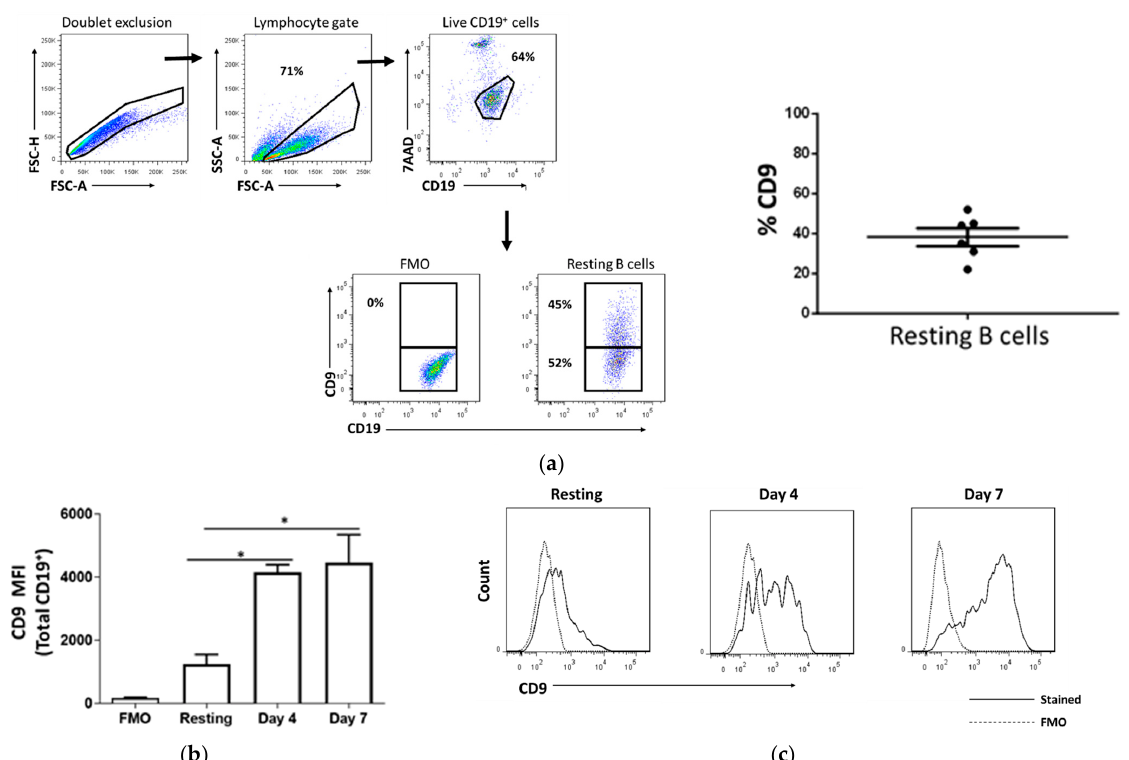
Figure 1. CD9 is expressed in resting tonsillar B cells and upregulated upon T cell-like (TCL) stimulation. B cells were purified from the tonsil using magnetic beads and analyzed for phenotypic CD9 expression. ( a ) Gating strategy for CD19 + B cells and its CD9 expression. ( b ) Purified naïve B cells were activated with TCL stimulation cocktail, CD40-agonist/anti- IgM/IL-2. On day 4 and 7, subsequent changes in CD9 expression were assessed and compared between the resting and stimulated B cells. ( c) Representative histogram showing the mean fluorescence intensity (MFI) of CD9 in the resting and stimulated B cells. Error bars represent SEM; * p < 0.05. One-way ANOVA was performed to determine statistical significance. FMO, Fluorescence Minus One Control.